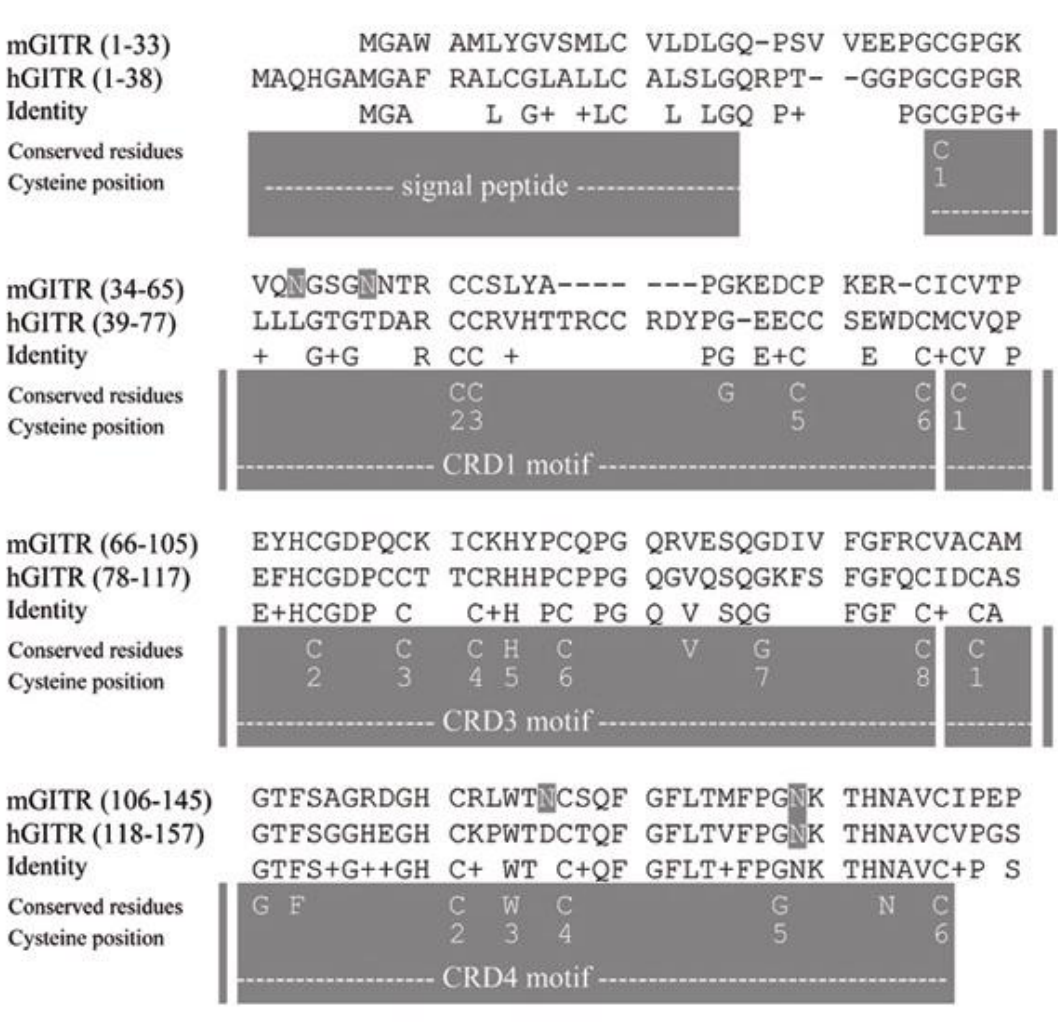
The CDR3 motif (Table 3) contains from 4 to 8 cysteines forming disulfide bonds in a way different from that of the canonical CRD: C1 with C4, C2 (if present) with C3 (if present), C5 (if present) with C7 (if present) and C6 with C8, as demonstrated by Banner et al. in the